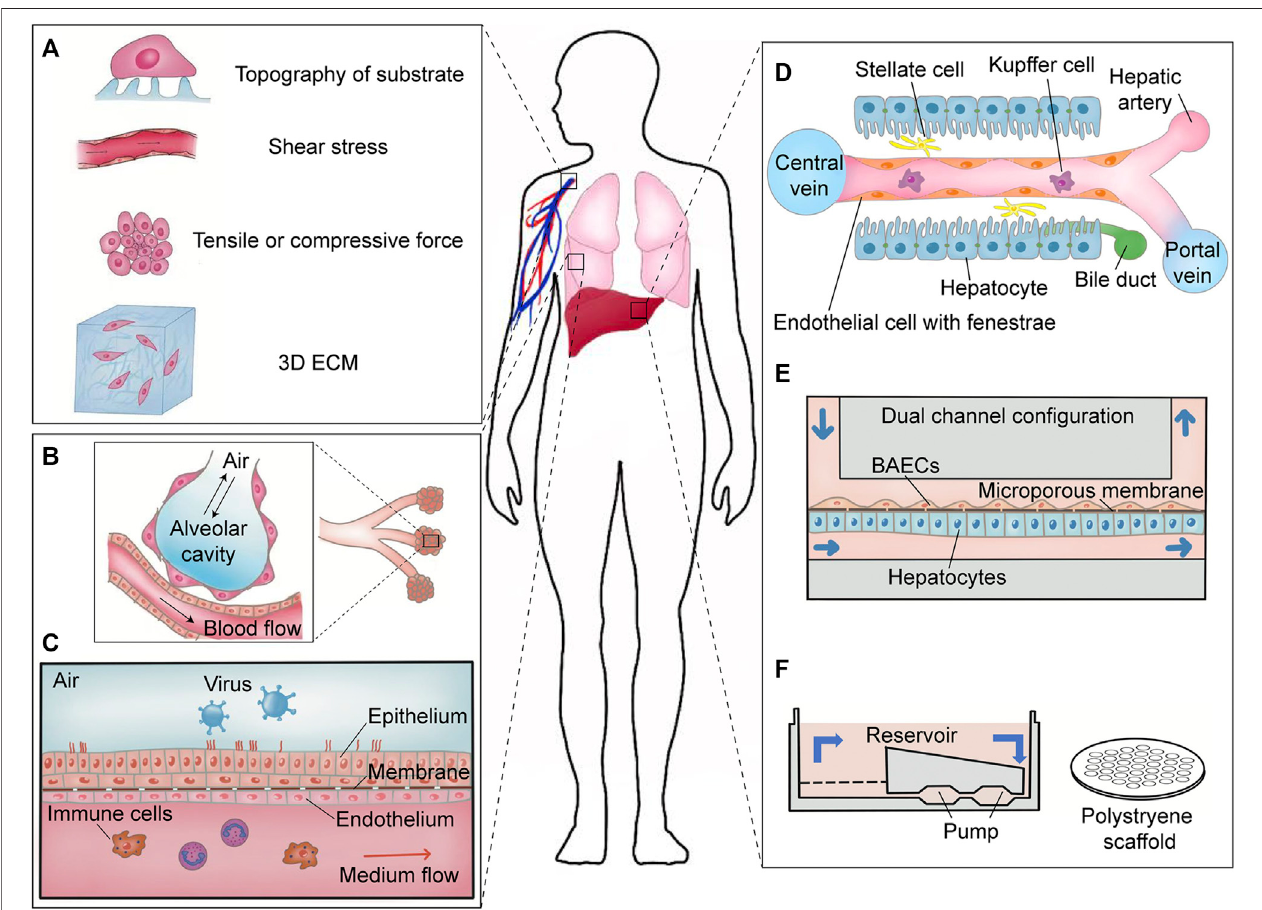
FIGURE2 | Extracellularmechanical forces in vivo and organ-on-a-chip models for virology in vitro . (A) Extracellular mechanical forces existing inthe human body. Extrinsic physical parameters are ubiquitous in vivo like topography of the substrate formed by ECM, shear stress from fl uid fl ow, tensile or compressive forces, and 3D ECM. (B) Physiological microenvironment in the human pulmonary alveoli. Shear force generated by blood fl ow and tensile force exerted on the alveolar cavity are important mechanical parameters for respiratory virus infection. (C) Schematic diagram of lung-on-a-chip. Adapted from ref. (Si et al., 2021). This biochip reconstitutedthealveolarmicroenvironmentincludingsimulatingblood fl owandairexchange. (D) Physiologicalmicroenvironmentinhumanliversinusoid.Adaptedfrom ref. (Ehrlich et al., 2019). Shear stress derived from biological fl ow is a crucial factor for maintaining the differentiation of hepatocytes in vitro . (E) Schematic diagram of a dualchannelmicrodevicemimickinghepaticsinusoid.Adaptedfromref.(Kangetal.,2015). (F) Schematicdiagramofanotherliver-on-a-chip.Adaptedfromref.(Ortega- Prieto et al.,